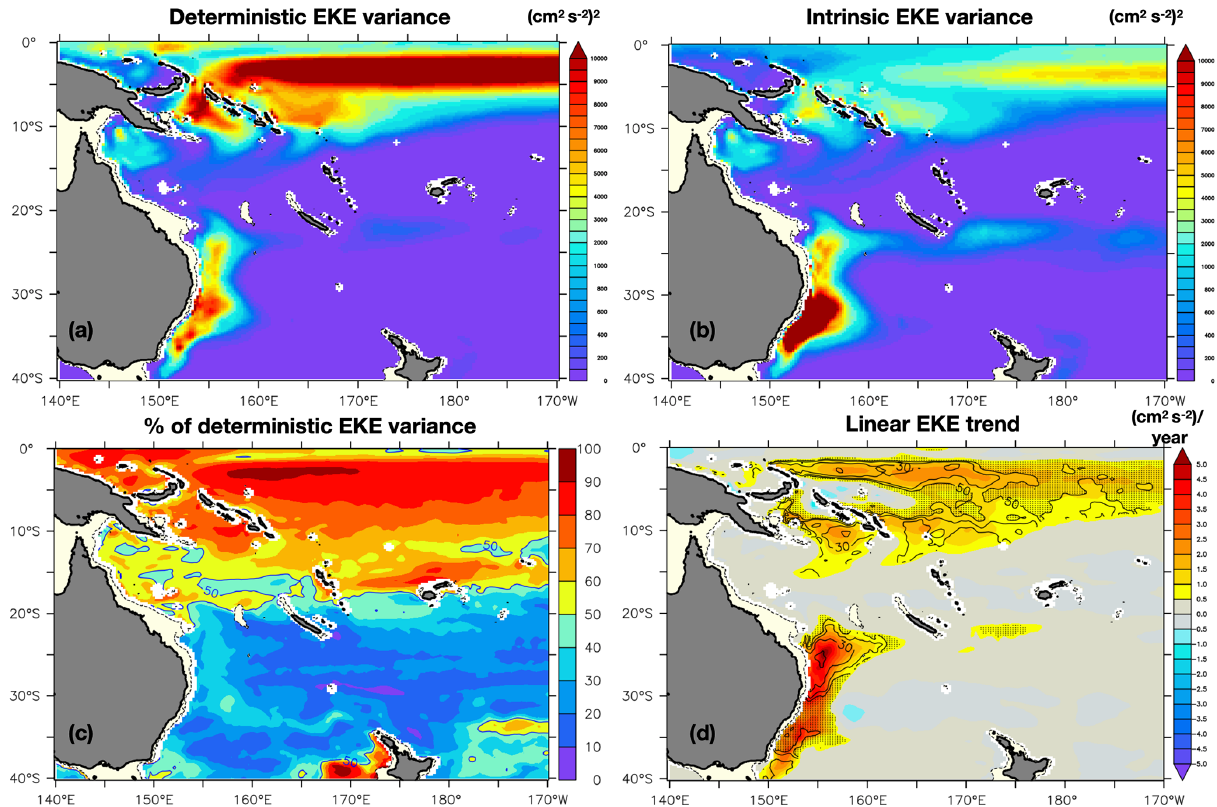
Figure 5. (a) Deterministic interannual variance of the EKE: 1980–2015 variance of ensemble mean low-pass-filtered 100m EKE. (b) In- trinsic interannual variance: ensemble mean of the squared deviation of the low-pass-filtered 100m EKE in each member from the ensemble mean. (c) Ratio R LF of the deterministic EKE variance to the total EKE variance, given as a percentage. (d) 100m EKE ensemble mean linear trend (in colors, cm 2 s − 2 yr − 1 ) and ratio of the spread between these linear trends and the deterministic trend (contours in percentage). The hatched areas show regions where the spread of these 1980–2015EKE trends is higher than 50% of the ensemble mean